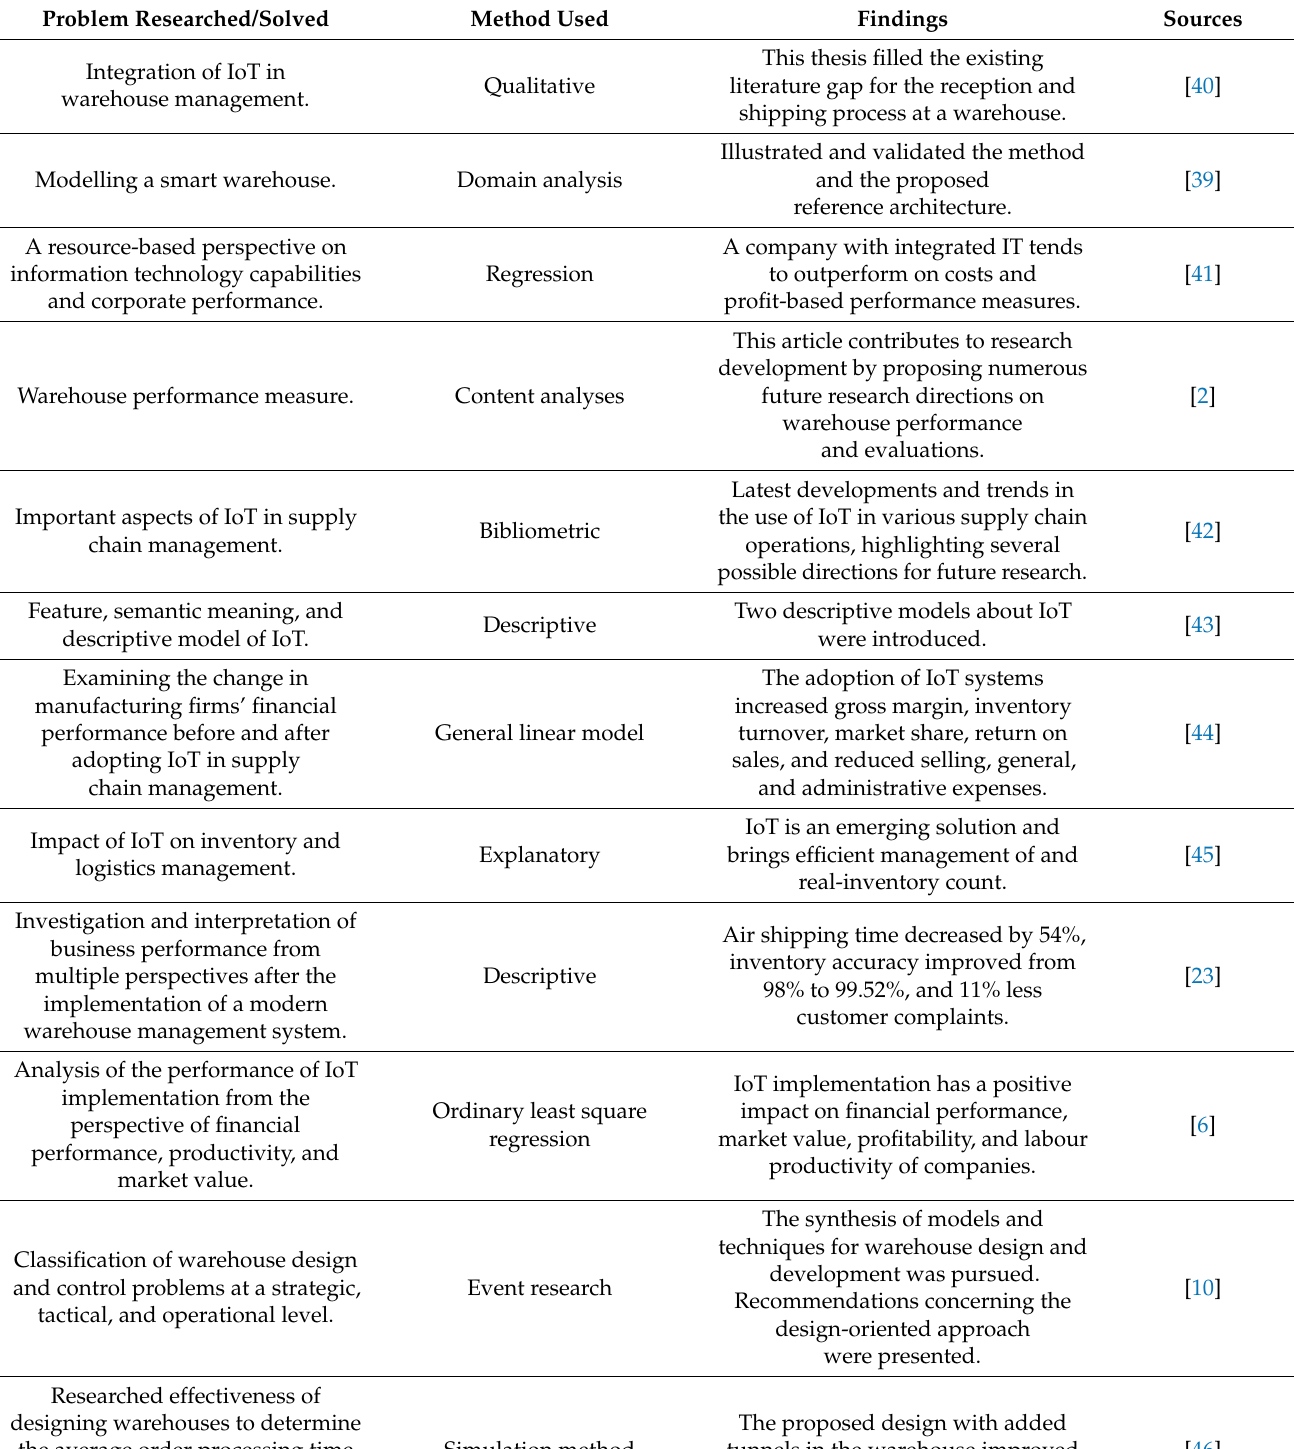
Table 2. Concept of IoT used in scientific